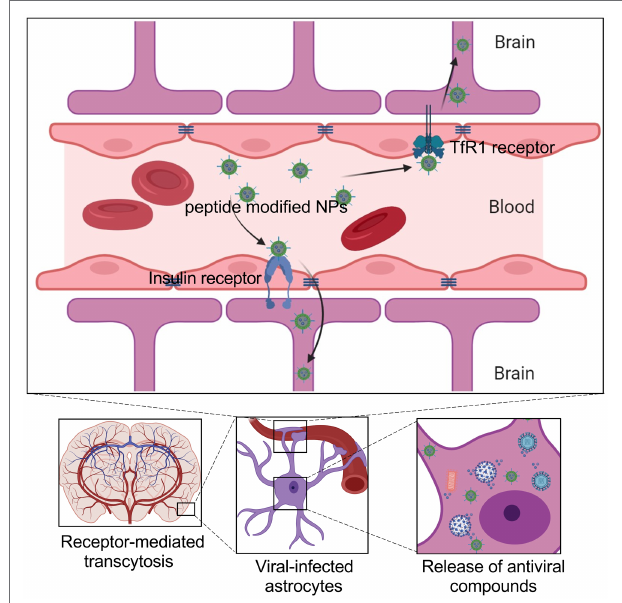
FIGURE 2 | Schematic showing the brain delivery of NPs across the BBB, which can be administered via the intravenous route. NPs penetrate the BBB through receptor-mediated transcytosis by coupling peptides or antibodies that enable nanoparticles to bind to receptors on the surface of endothelial cells. Such NPs encapsulate the antiviral drugs and specifically release them in the infected